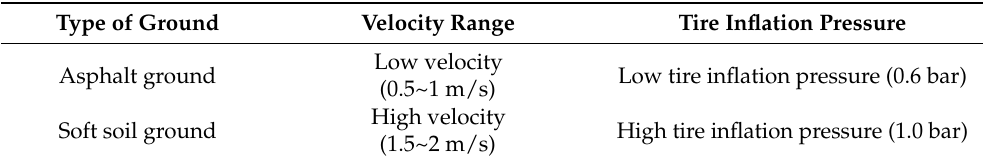
Table 4. Experiments of measuring the slip ratio for tractor driving wheels under multiple working